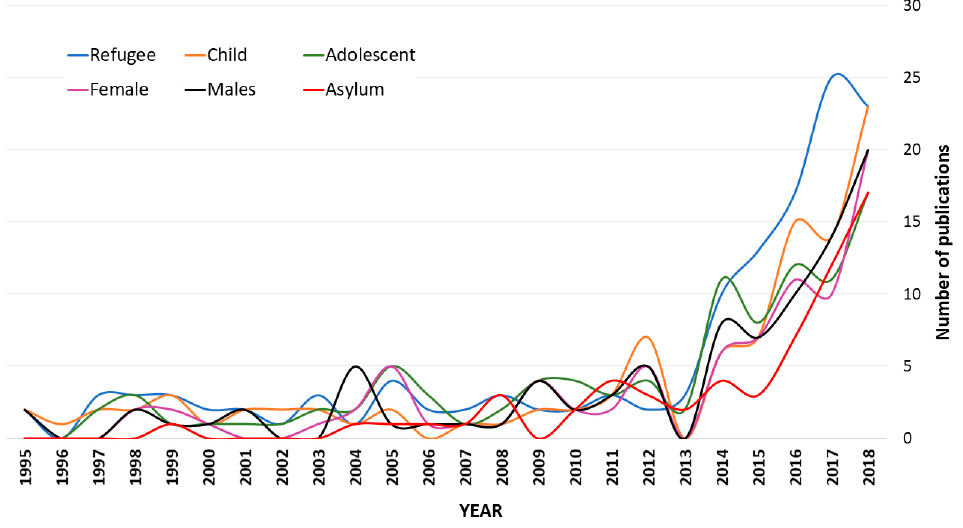
Figure 8. Temporal evolution of the main keywords.